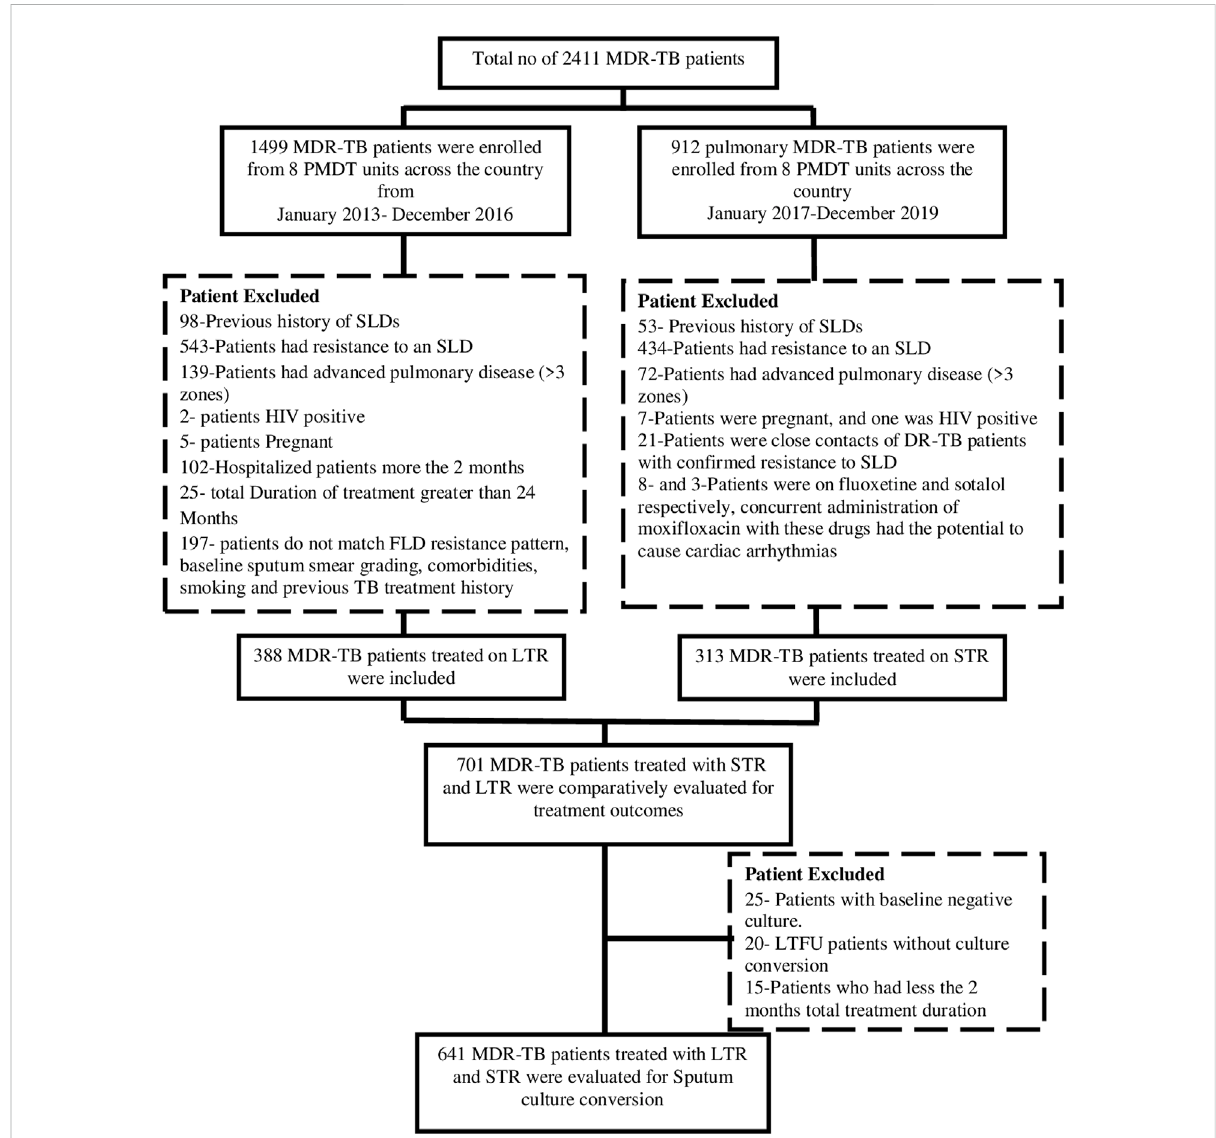
FIGURE 1 FowchartofstudyparticipantsincludedinthestudySLDs,Second-linedrugs;STR,Shortertreatmentregimen;LTR,Longertreatmentregimen; LTFU, Lost to follow-up; MDR-TB, Multi-drug resistant